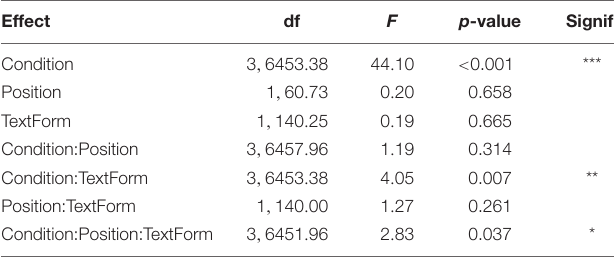
TABLE 4 | Mixed model ANOVA table for Experiments L1A and L1B (native participants). Effect df F p -value Signif.